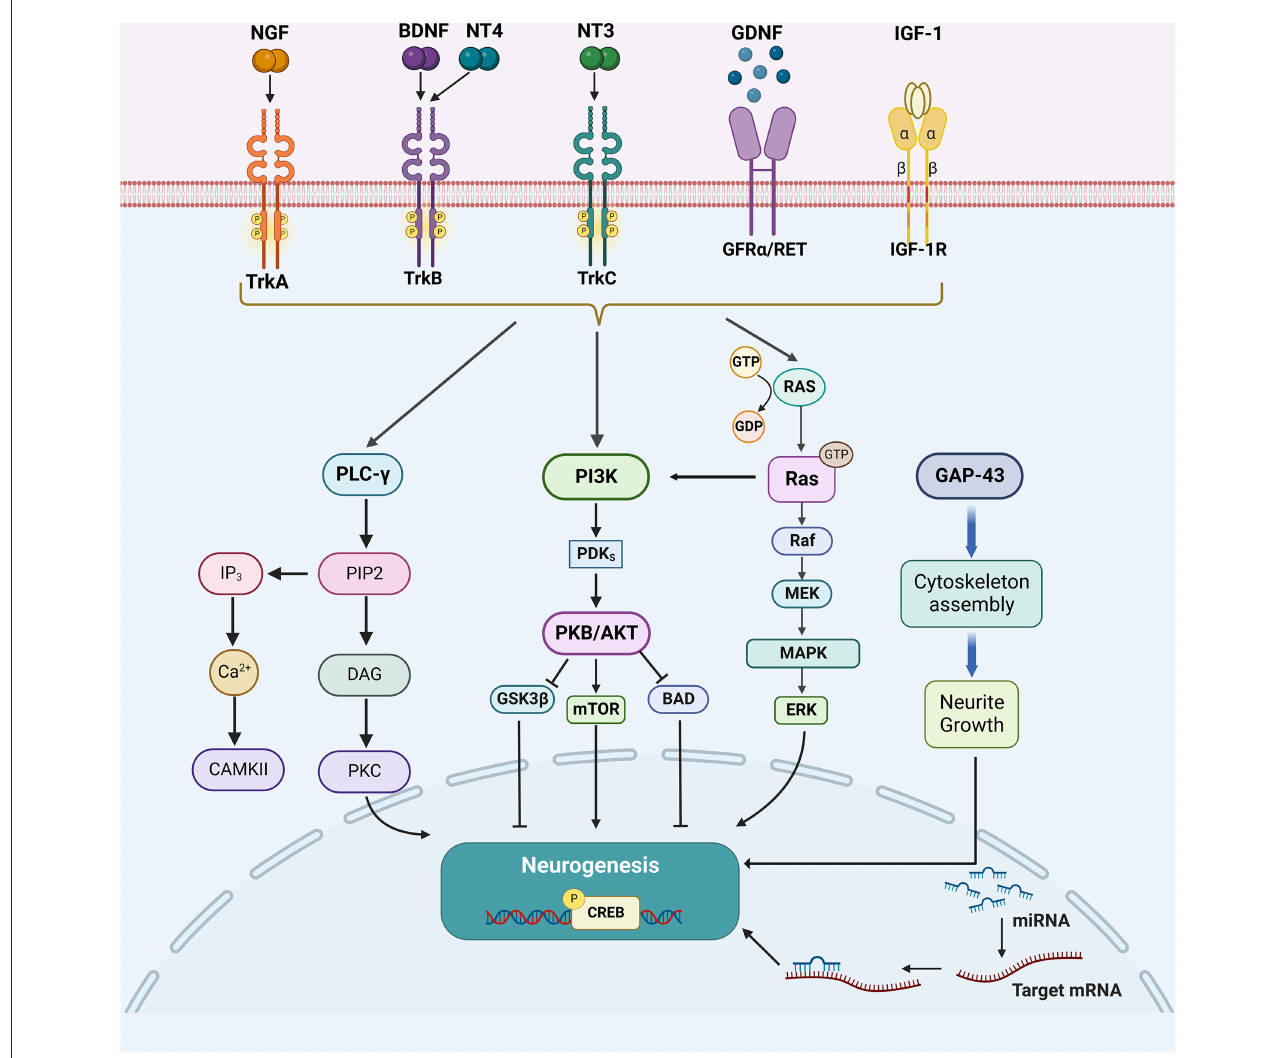
FIGURE1 The enhancing factors of neurogenesis and their major downstream signaling pathways. After the cerebral ischemic injury, multiple growth factors (NGF, BDNF, NT3/4, and GDNF), other growth proteins (GAP-43 and IGF-1), and miRNAs could promote neurogenesis. Their downstream signaling cascades, mainly include PLC- γ /PKC, PI3K/Akt, MAPK/ERK, and Wnt/ β -catenin